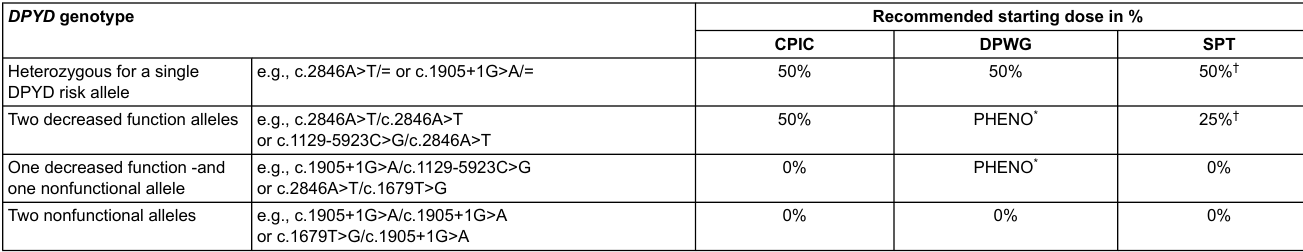
Table 3: Fluoropyrimidine dosing recommendations according to DPYD